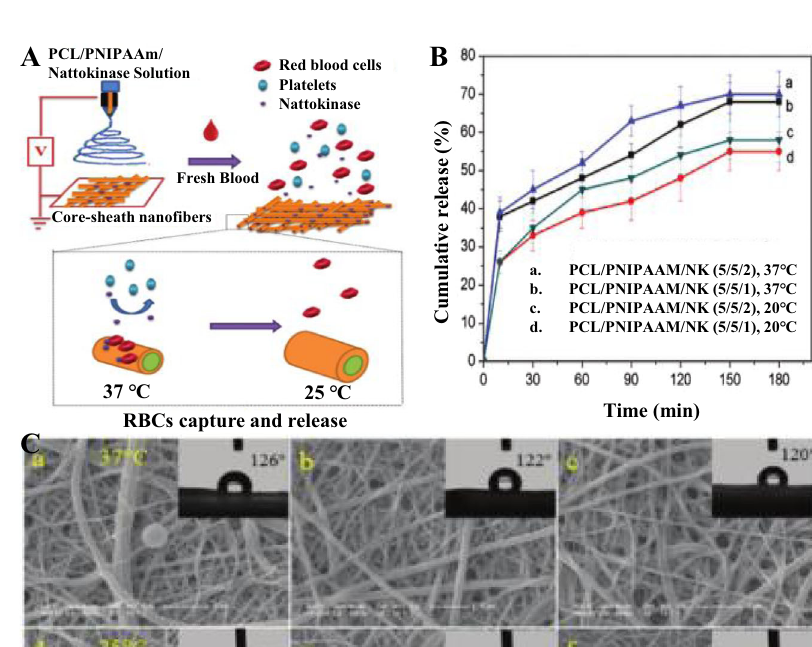
cellsPCL/PNIPAAm/ NattokinaseSolution